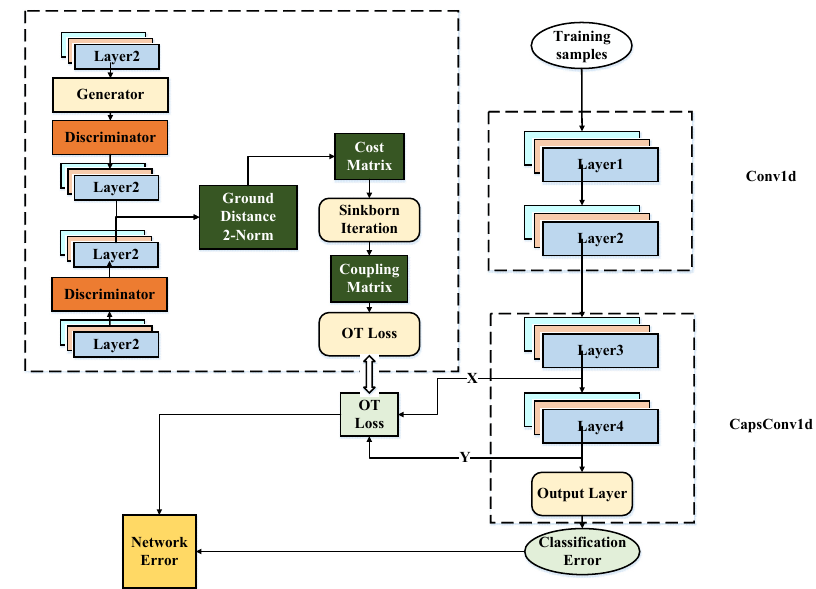
Figure 3. Flowchart for the entire training and testing process.